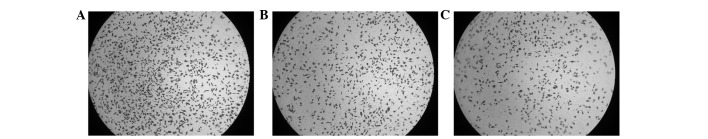
Inhibition of vertical invasion by CoCl2. CoCl2 markedly inhibits the invasive ability of MG63 cells. (A) 0 μM; (B) 150 μM; (C) 300 μM CoCl2. Magnification, ×100/